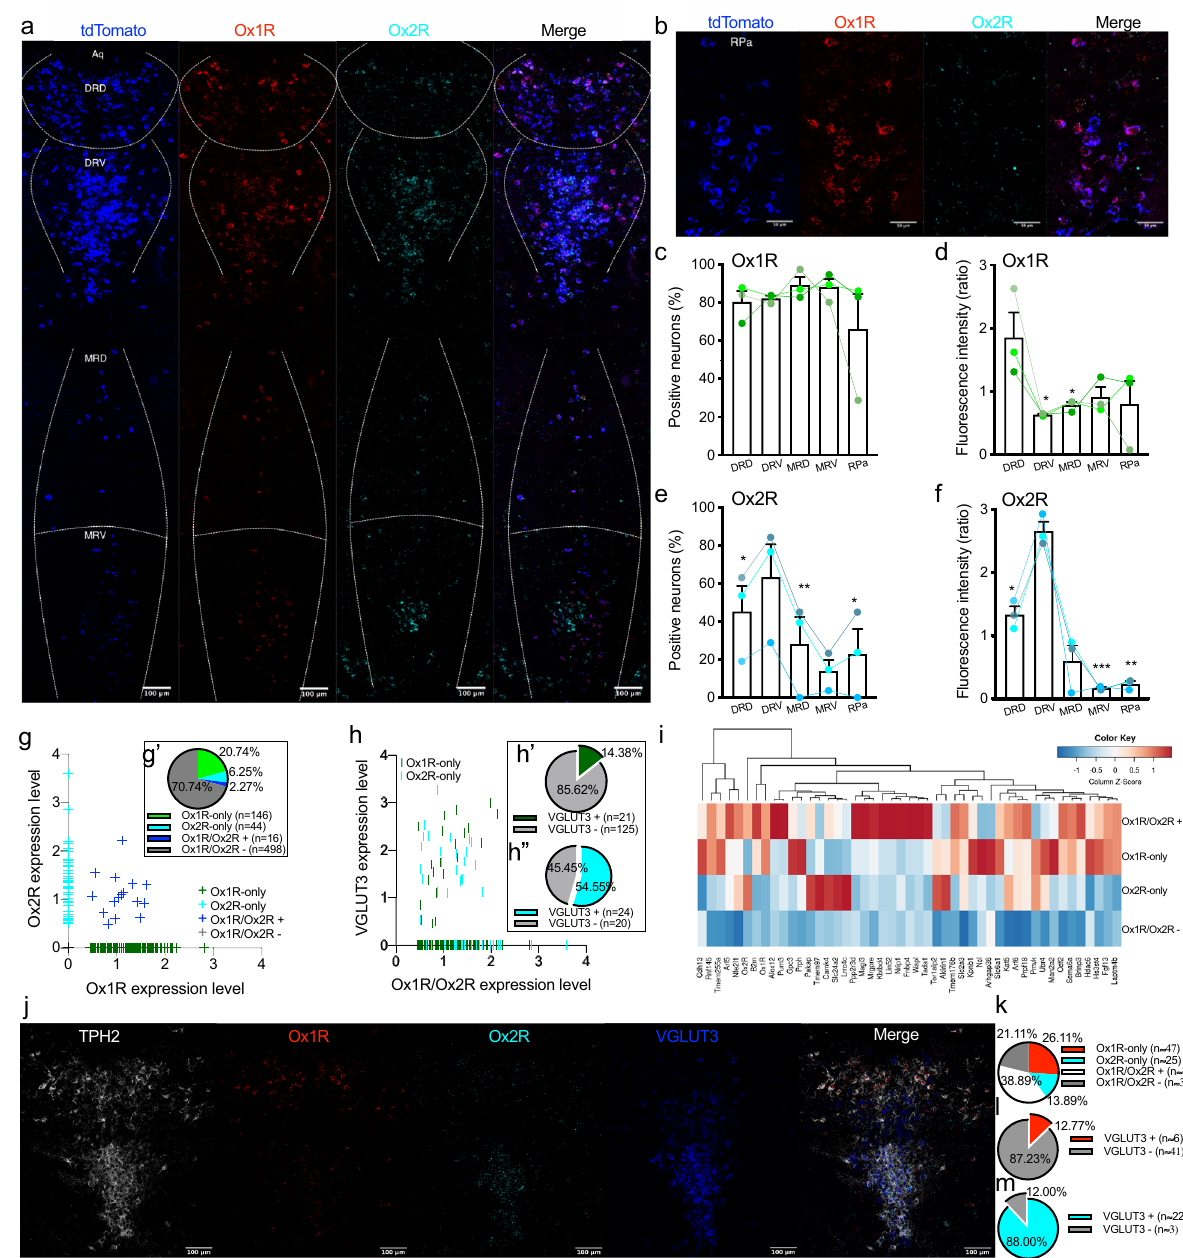
Fig. 1 Distribution of Ox1R and Ox2R in serotonergic neurons of the raphe nucleus of a SERT tdTomato mouse. a Representative images of RNAscope in situ hybridization in the dorsal raphe nucleus (dorsal (DRD), ventral (DRV)), and median raphe nucleus (dorsal (MRD), ventral (MRV)). b Representative images of RNAscope in situ hybridization in the raphe pallidus (RPa). c , e Percentages of Ox1R or Ox2R positive neurons in serotonergic neurons. d , f The average of relative fl uorescence intensity of Ox1R or Ox2R signal in each serotonergic neuron. Fluorescence was normalized by the mean of all regions for each mouse. Blue, tdTomato; red, Ox1R; cyan, Ox2R. Scale bar: 100 µ m in ( a ) and 50 µ m in ( b ). n = 3. Data are represented as means±SEM. d DRV: p = 0.035, MRD: p = 0.036; e DRD: p = 0.049, MRD: p = 0.0081, RPa: p = 0.028; f DRD: p = 0.010, MRV: p = 0.0008, RPa: p = 0.0099. * p <0.05, ** p <0.01, *** p <0.001; compared to DRD ( d ) or DRV ( e , f ), as determined by paired two-tailed t -test ( c , e ) or ratio paired two-tailed t -test ( d , f ). Analysis of published scRNA-Seq data of serotonergic neurons in dorsal raphe nucleus (DR) 30,31 : g Scatter plot of raw cell read counts of Ox1R and Ox2R, g ’ percentages of serotonergic neurons only expressing Ox1R (Ox1R-only) or Ox2R (Ox2R-only) and those expressing both or none of Ox1R and Ox2R (Ox1/2R + or Ox1/2R − ), h scatter plot of raw vesicular glutamate transporter 3 (VGLUT3) counts against raw Ox1R or Ox2R counts, h ’ percentages of VGLUT3 positive ( + ) and negative ( − ) neurons in Ox1R-only and h ” Ox2R-only serotonergic neurons, and i heat map of gene counts for cells with column-wise z-scores. Mean gene abundance was calculated per gene (x-dimension) and group (y-dimension). Column-wise z-scoring (per gene) was applied to make expression visually comparable between groups independent of average gene abundance levels. j Representative images of RNAscope in situ hybridization in the dorsal raphe nucleus (scale bar: 100 µ m), and analysis: k percentages of Ox1R-only, Ox2R-only, Ox1/2R + and Ox1/2R − serotonergic neurons; percentages of VGLUT3 positive neurons in ( l ) Ox1R-only and ( m ) Ox2R-only serotonergic neurons. Gray, tryptophan hydroxylase isoform 2 (TPH2); red, Ox1R; cyan, Ox2R; blue, VGLUT3. n = 3. Source data are provided as a Source Data fi